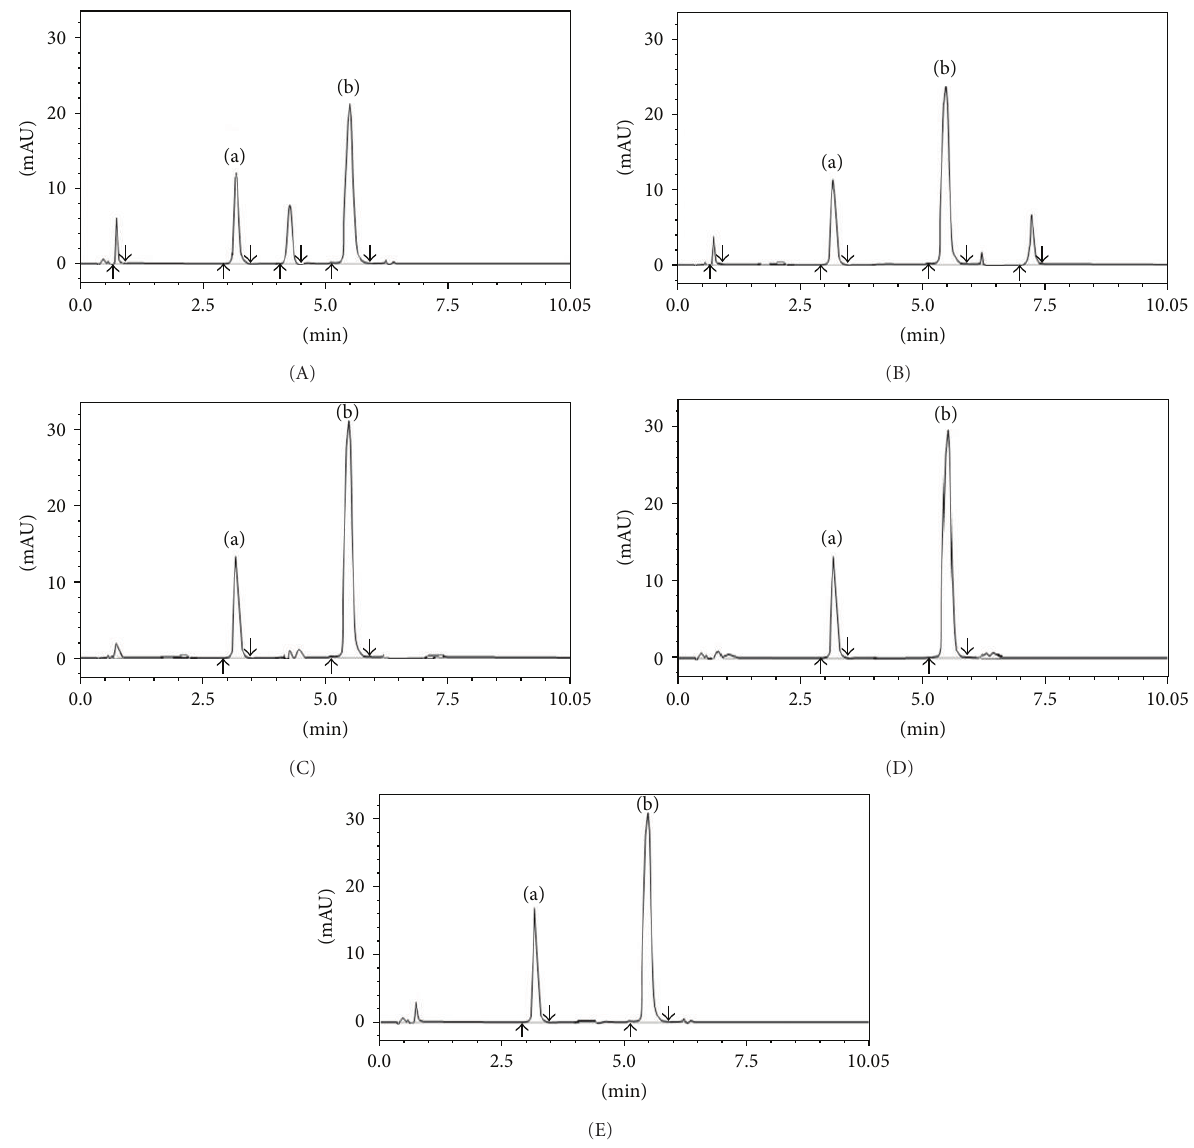
Figure 4: HPLC chromatograms obtained for (a) TLM and (b) ATV from degradation study: showing acid hydrolysis (0.1M HCl, 60 ∘ C, 1hr) (A); alkaline hydrolysis (0.1M NaOH, 60 ∘ C, 1hr) (B); oxidative degradation (3% H 2 O 2 , 60 ∘ C, 1hr) (C); dry heat degradation (60 ∘ C, 1hr) (D); and photolytic degradation (UV-chamber, 254 nm, 24 hrs)